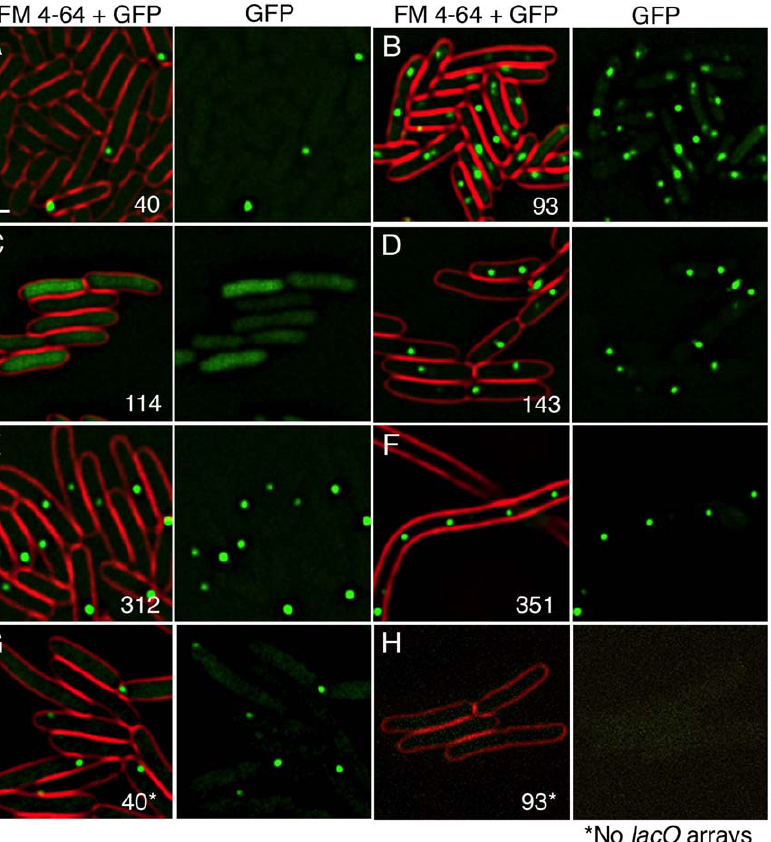
Figure 3. Binding of LacI-GFPi proteins to lacO arrays near the E.coli terminus of replication in growing cells. Numbers correspond to the location of GFP insertion into LacI. (A) LacI-40-GFPi localizes in foci near the cell poles, typical of inclusion bodies. (B) LacI-93-GFPi localizes as foci at midcell. (C) LacI-114-GFPi localizes to the cytoplasm. (D) LacI-143-GFPi, (E) LacI-312-GFPi localize as foci at midcell. (F) LacI-351-GFPi localizes as foci in filamentous cells. (G) LacI-40-GFPi forms foci in the absence of the lacO arrays (in strain CSH140), while (H) LacI-93-GFPi no longer assembles foci. Scale bar in A, 1 m m.